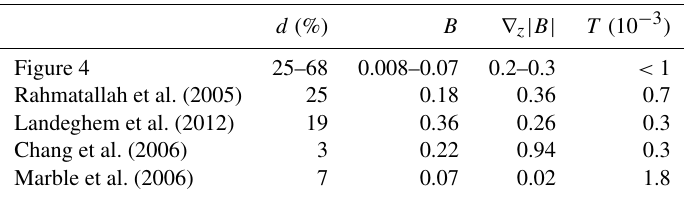
Figure 4. (a) Adaptable magnet geometry, with a section removed for clarity, shows a toroidal array of disk magnets in grey, magnet control pieces in black, and the magnetisation direction as white arrows. The resulting magnetic field intensity contours are shown after having reached the minimum energy configuration and feature a region above the magnet array with a laterally uniform gradient along the depth. In (b) , the top-left and top-centre plots show the field contours and minimum discernible thickness for the magnet configuration in (a) as defined by Eq. (9). The remaining minimum discernible thickness profiles show other equilibrium configurations arising from moving the control pieces in z ∈ {− 0 . 06 , 0 . 08 } , thereby rotating the cylinders by θ ∈ {− 32 ◦ , 27 ◦ } . These are plotted on normalised dimensions going from 0.05 to 0.7 in relative penetration depth and 0 to 0.3 radially. The normalised magnetic field intensity, in normalised milliunits, and its contour lines, are shown in black. Table 1. Normalised figures of merit, as described in Sect. 3, comparing the obtained results for the normalised penetration depth ( d ), magnetic field ( B ), normalised field gradient, and minimum discernible thickness ( T ) to